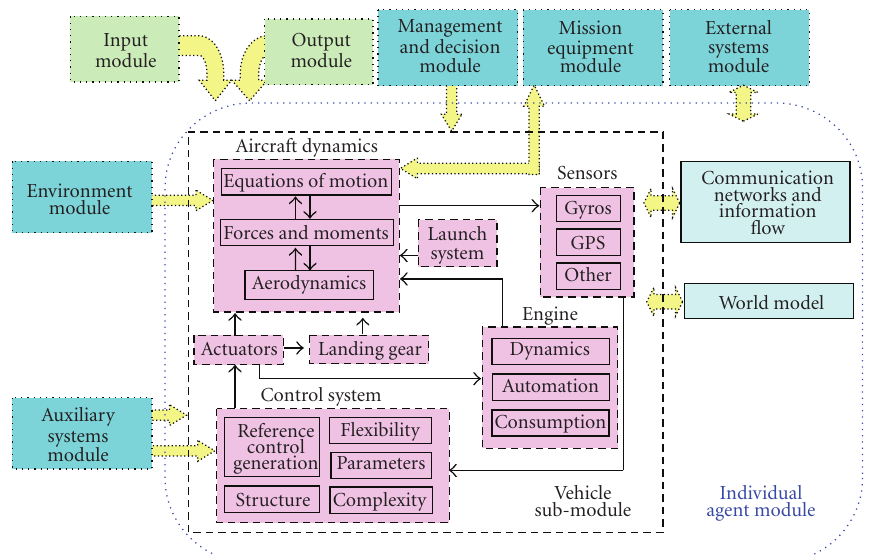
Figure 5: The individual agent module for an unmanned aerial vehicle.